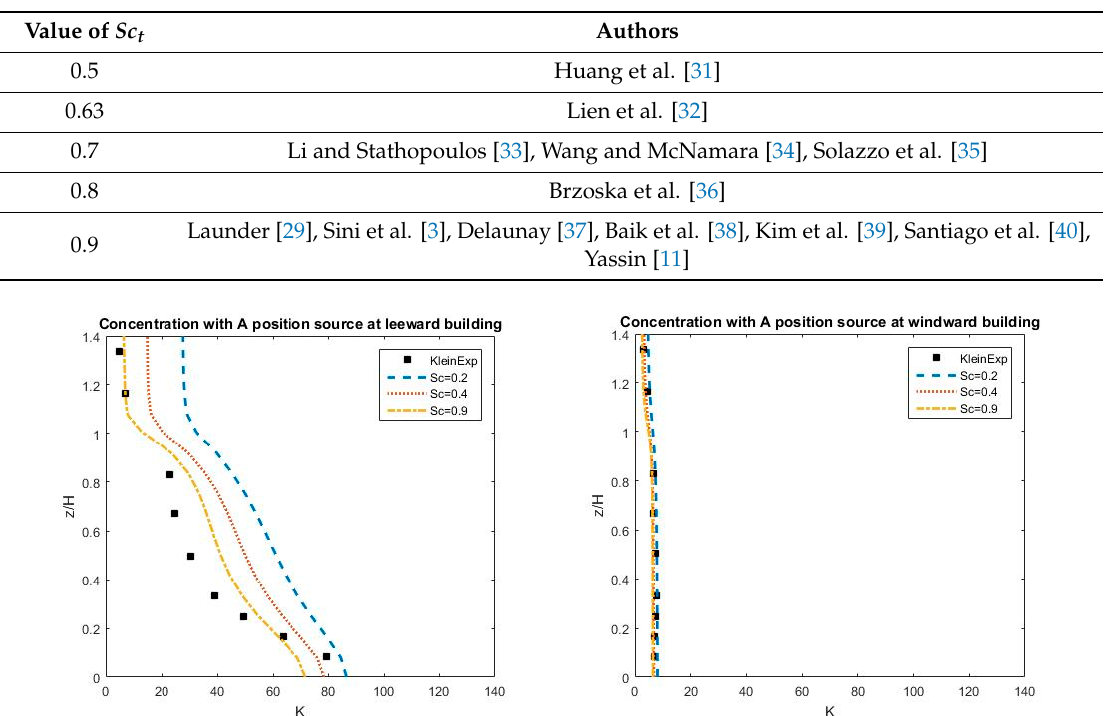
Table 2. Values of Sc t used in previous studies on building and urban di ff usion simulation